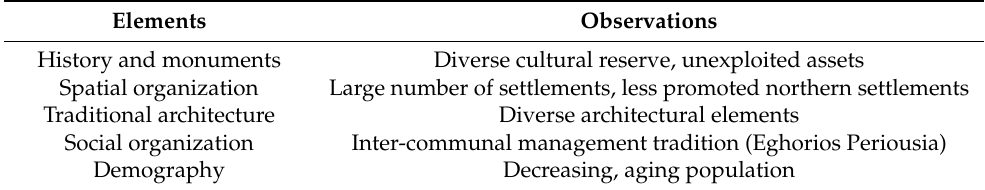
Table 1. Findings of study area analysis regarding Kythera’s special